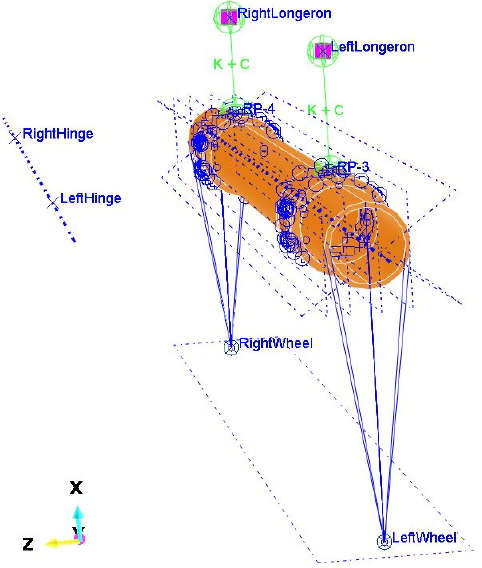
Figure 1. Complete model of the axle for simulations (front in Z direction).